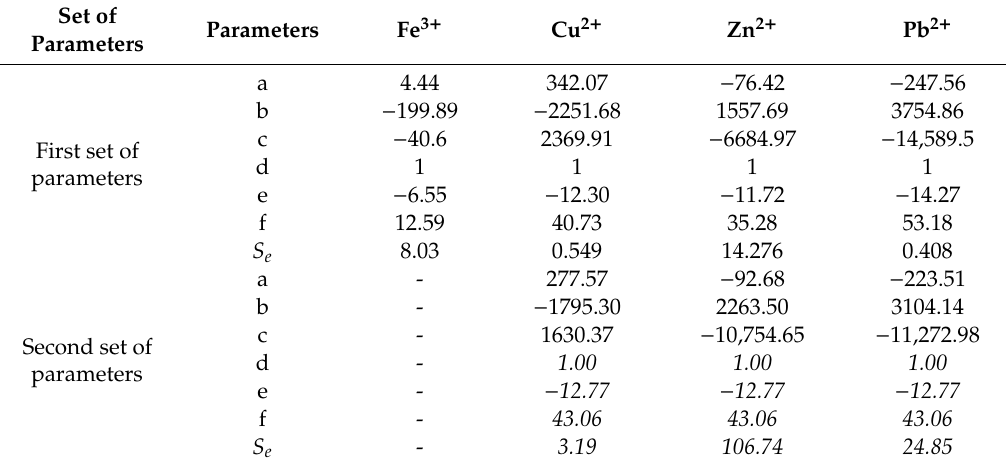
Table 6. Values of parameters in Equation